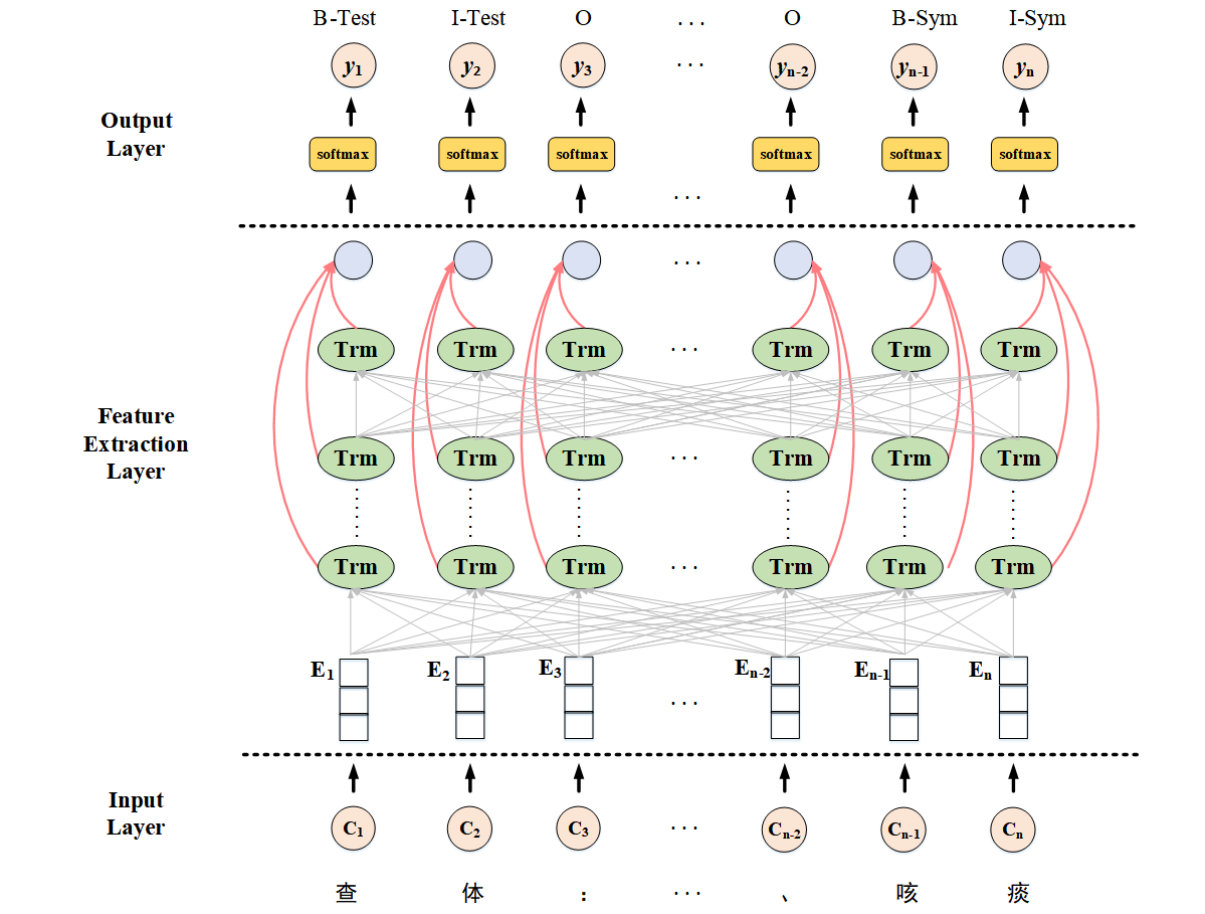
Figure 2. Multi-level representation learning for ER model. B-Sym: beginning of the noun phrase for the symptom entity; B-Test: beginning of the noun phrase for the test entity; C: input sentence; E: input embedding; I-Sym: middle of the noun phrase for the symptom entity; I-Test: middle of